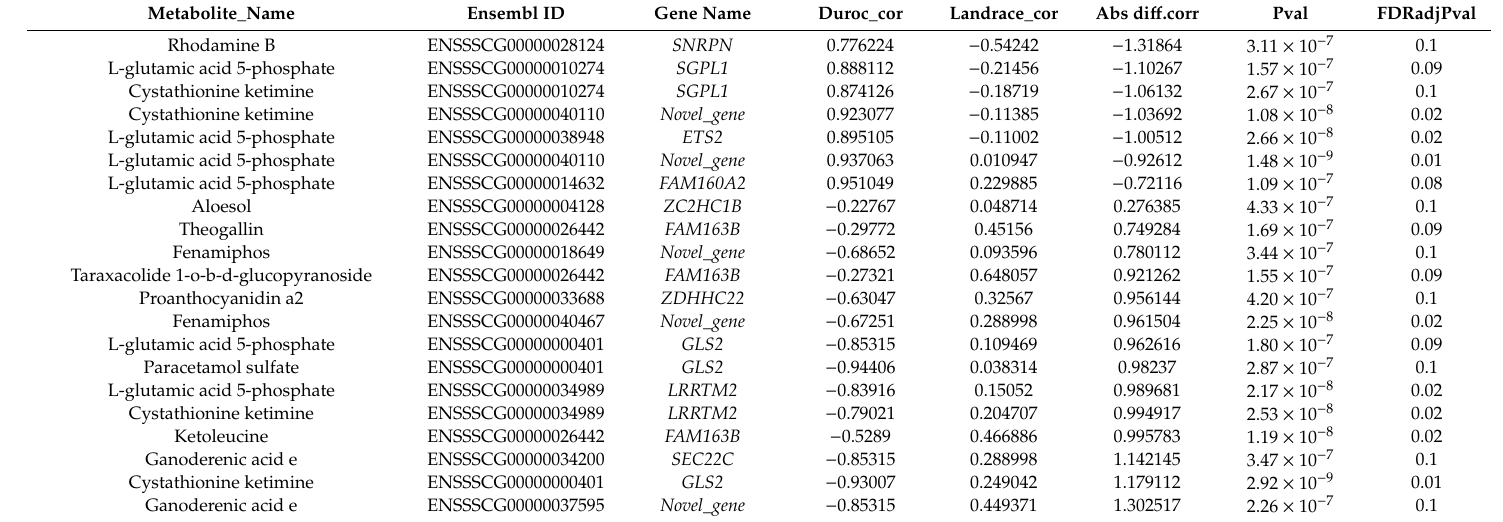
Table 1. Gene-metabolite interaction pairs from IntLIM for the breed-specific groups.